Question: How would you classify this visualization?
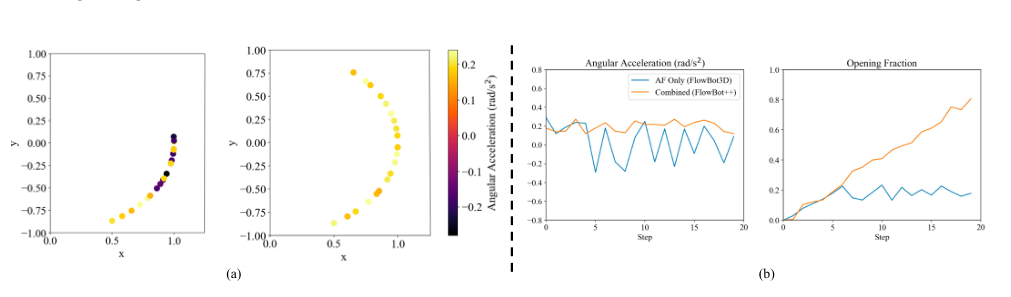
Answer: scatter